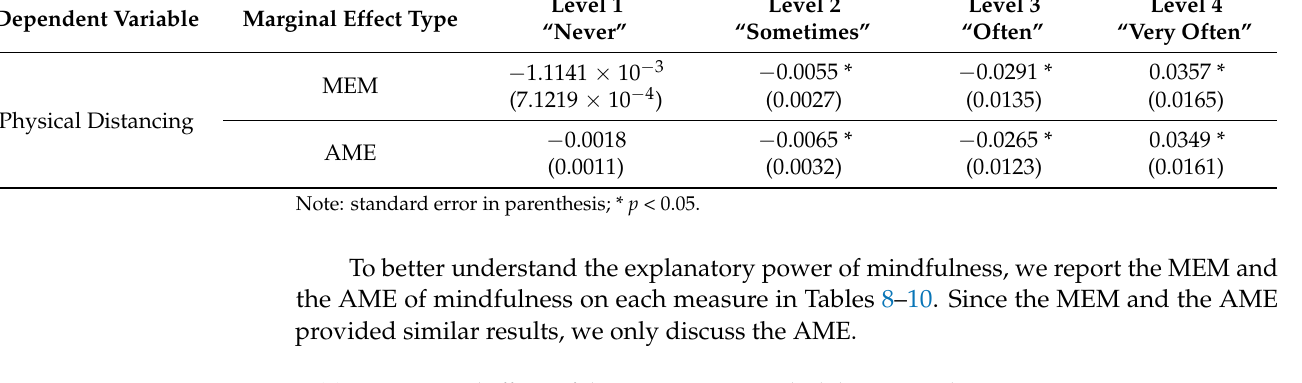
Table 10. Marginal effects of the MAAS scores on lockdown